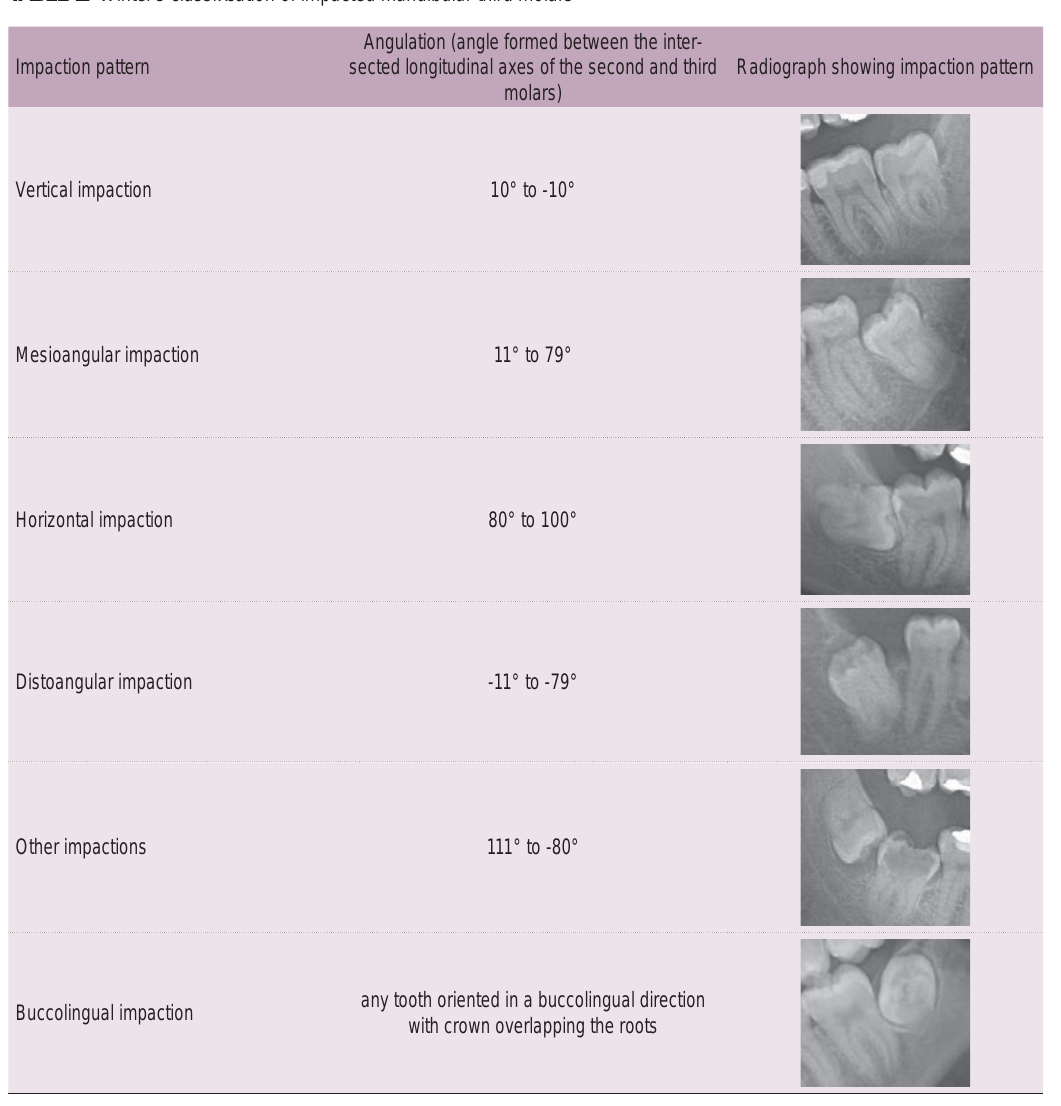
TABLE 1. Winter's classifi cation of impacted mandibular third